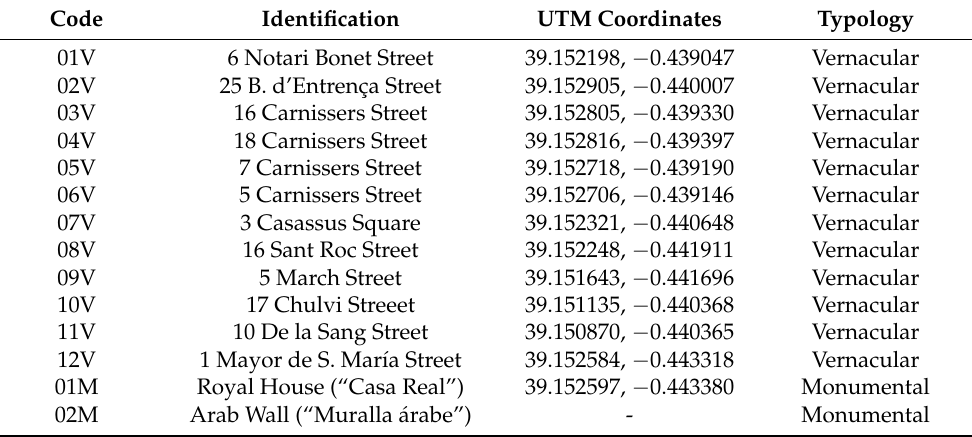
Table 2. Earthen heritage buildings in the historic town centre of Alzira.